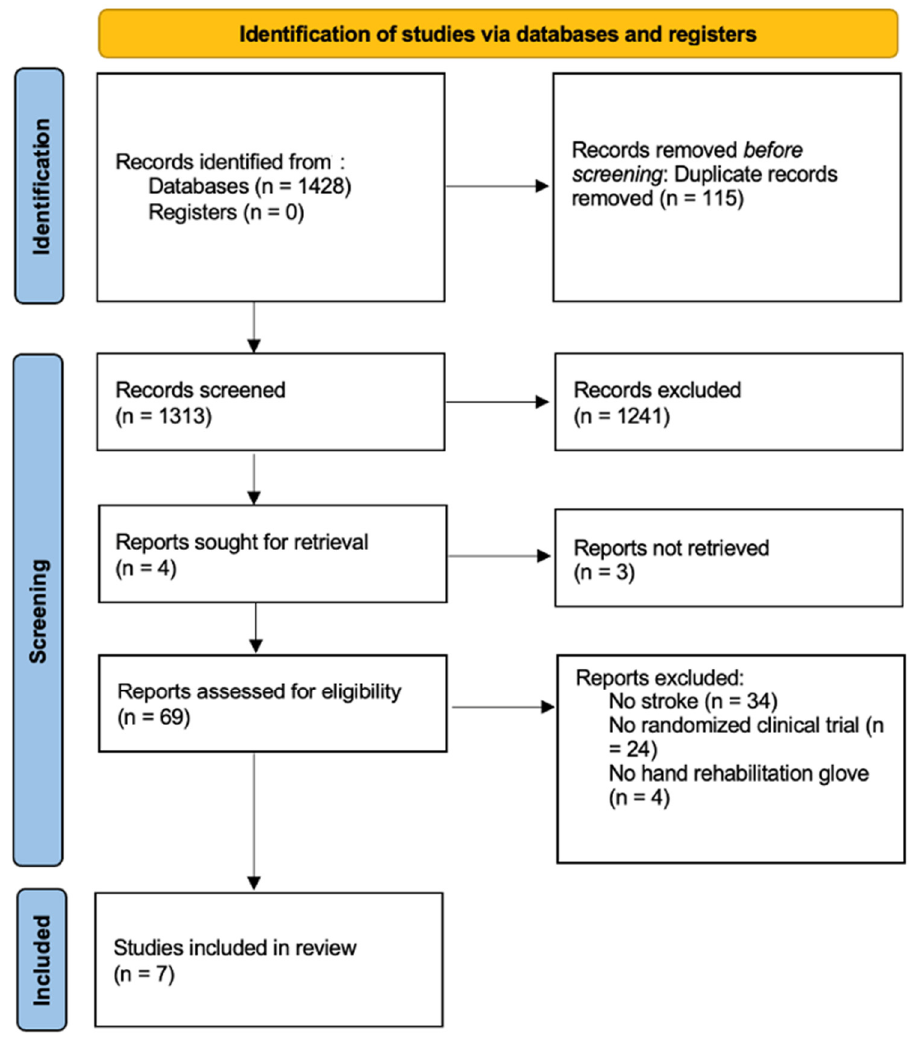
Figure 1. PRISMA Flowchart diagram.